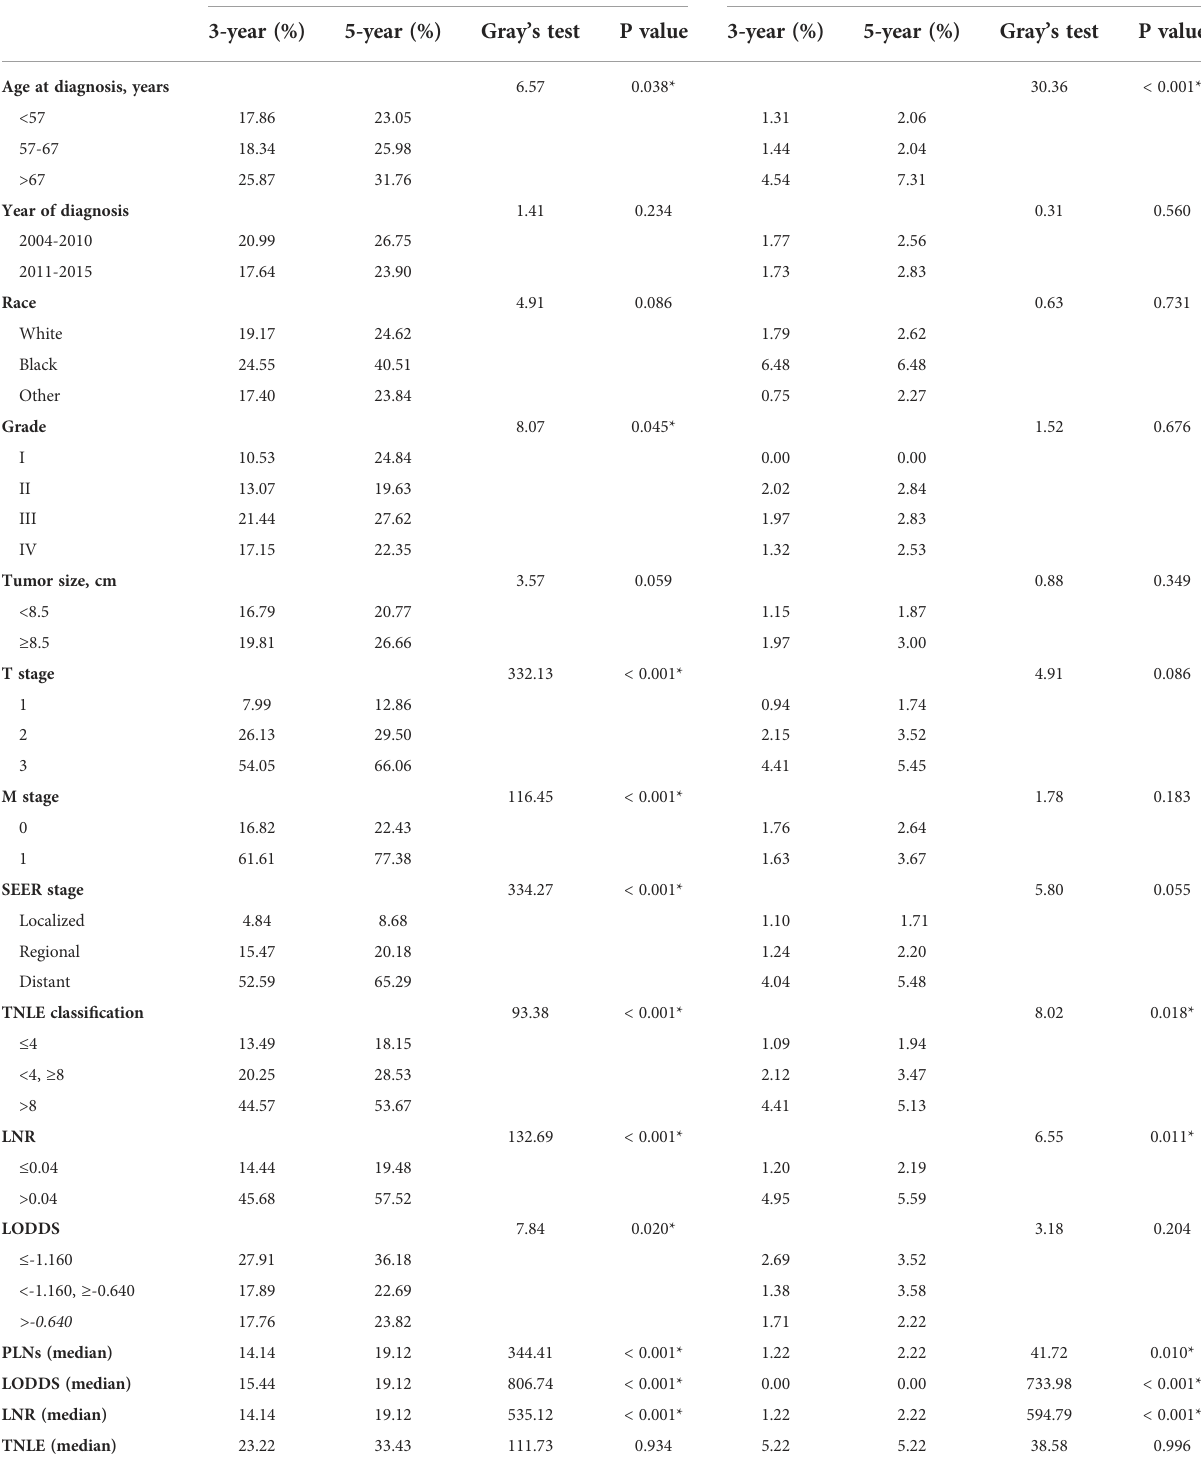
TABLE 2 The cumulative incidences for CSD and DOC.